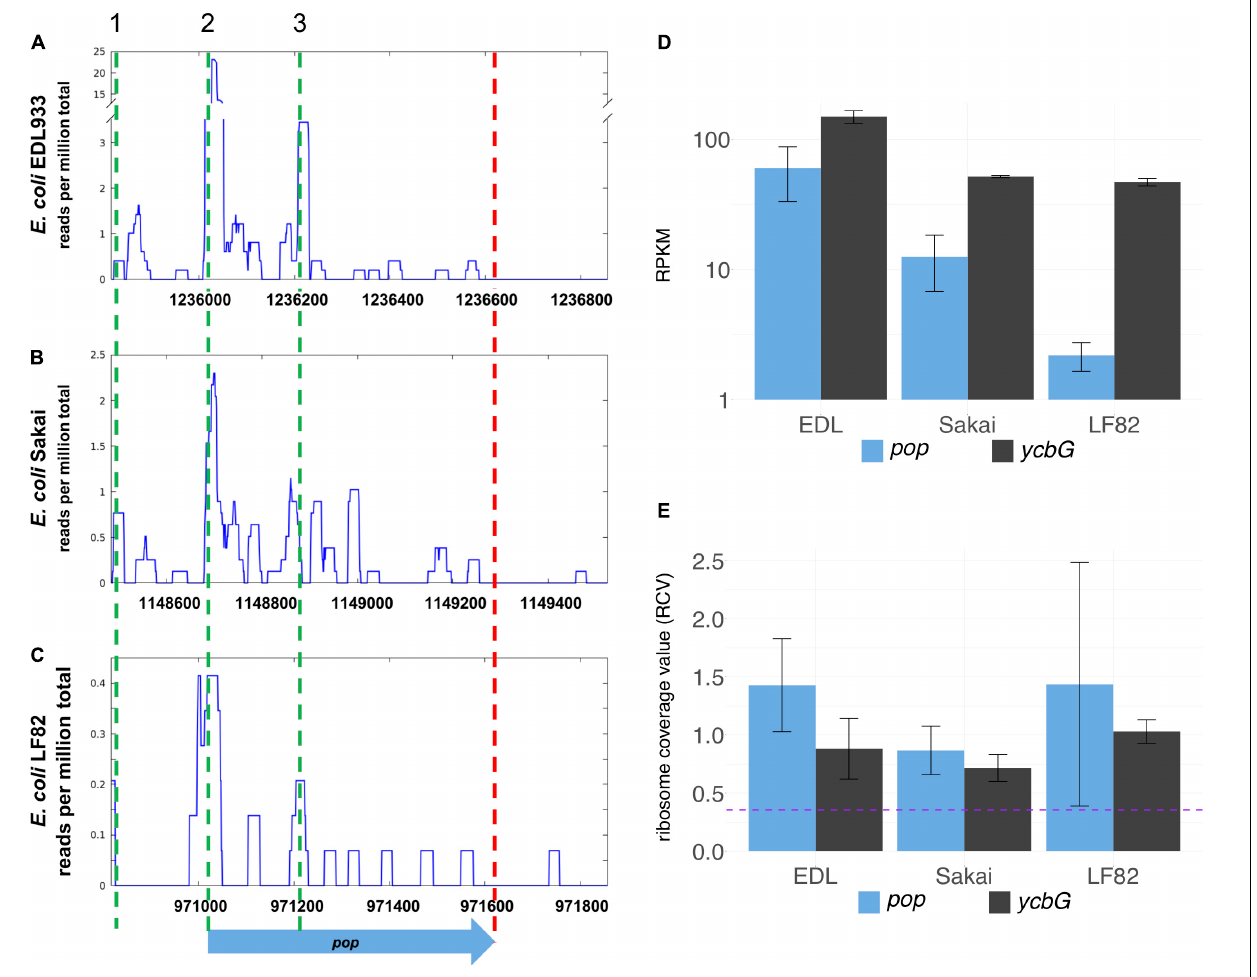
FIGURE 2 | Inter-strain comparison of pop translation. Alignment of sequence and ribosomal profiling reads of pop and its homologs across pathogenic E. coli strains O157:H7 EDL933 (A) , O157:H7 Sakai (B) , and LF82 (C) . Graphs show normalized sequencing reads (RPKM, reads per kilobase per million mapped reads) of ribosome profiling experiments in LB medium (A,B) or Schaedler broth (C) ; the sum signal of two biological replicates is visualized. Three putative start codons are indicated with green dashed lines in region 1 (TTG), 2 (CTG), and 3 (GTG). The stop codon is indicated by a red dashed line. (D) Averaged RPKM values of translation and (E) ribosomal coverage values (RCV) of overlapping gene pop and the upstream annotated gene ycbG of three E. coli strains. Purple dashed line in panel (E) : threshold for translated ORFs, RCV = 0.35. Error bars indicate both underlying values used for calculations.